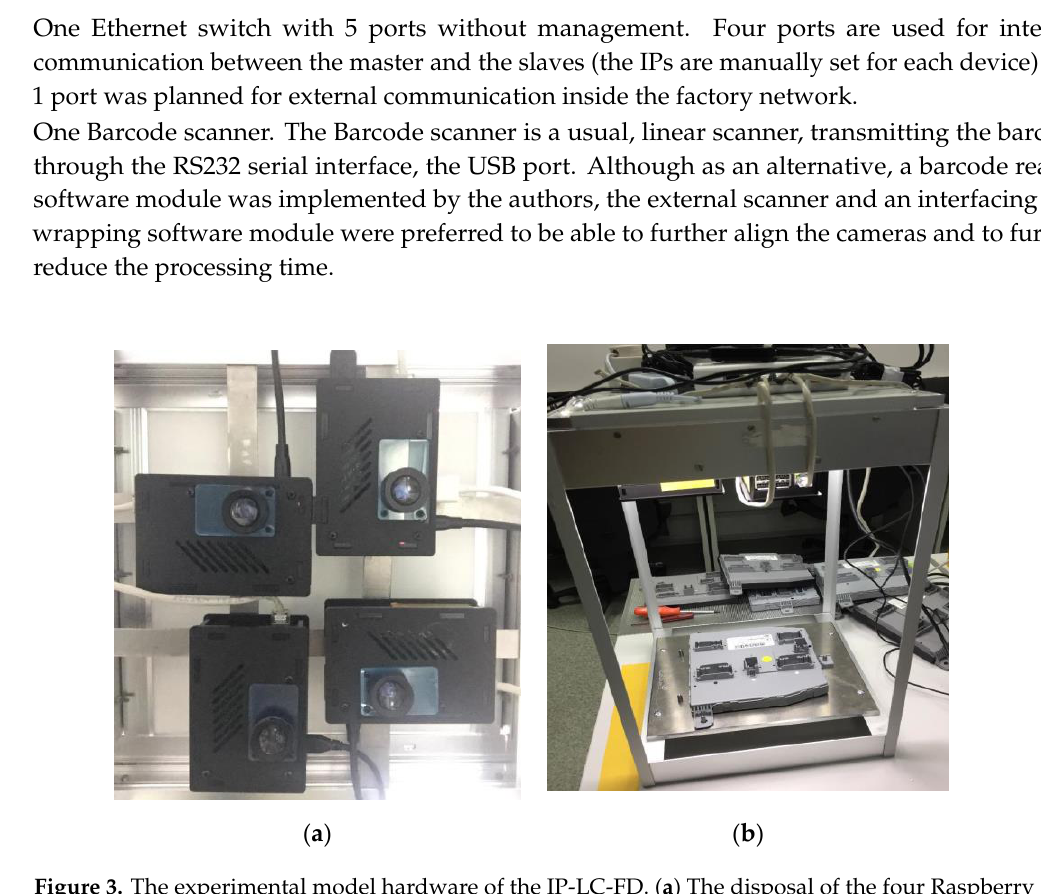
Figure 3. The experimental model hardware of the IP-LC-FD. ( a ) The disposal of the four Raspberry Pi–Pi camera ensembles. ( b ) The final experimental model stand.